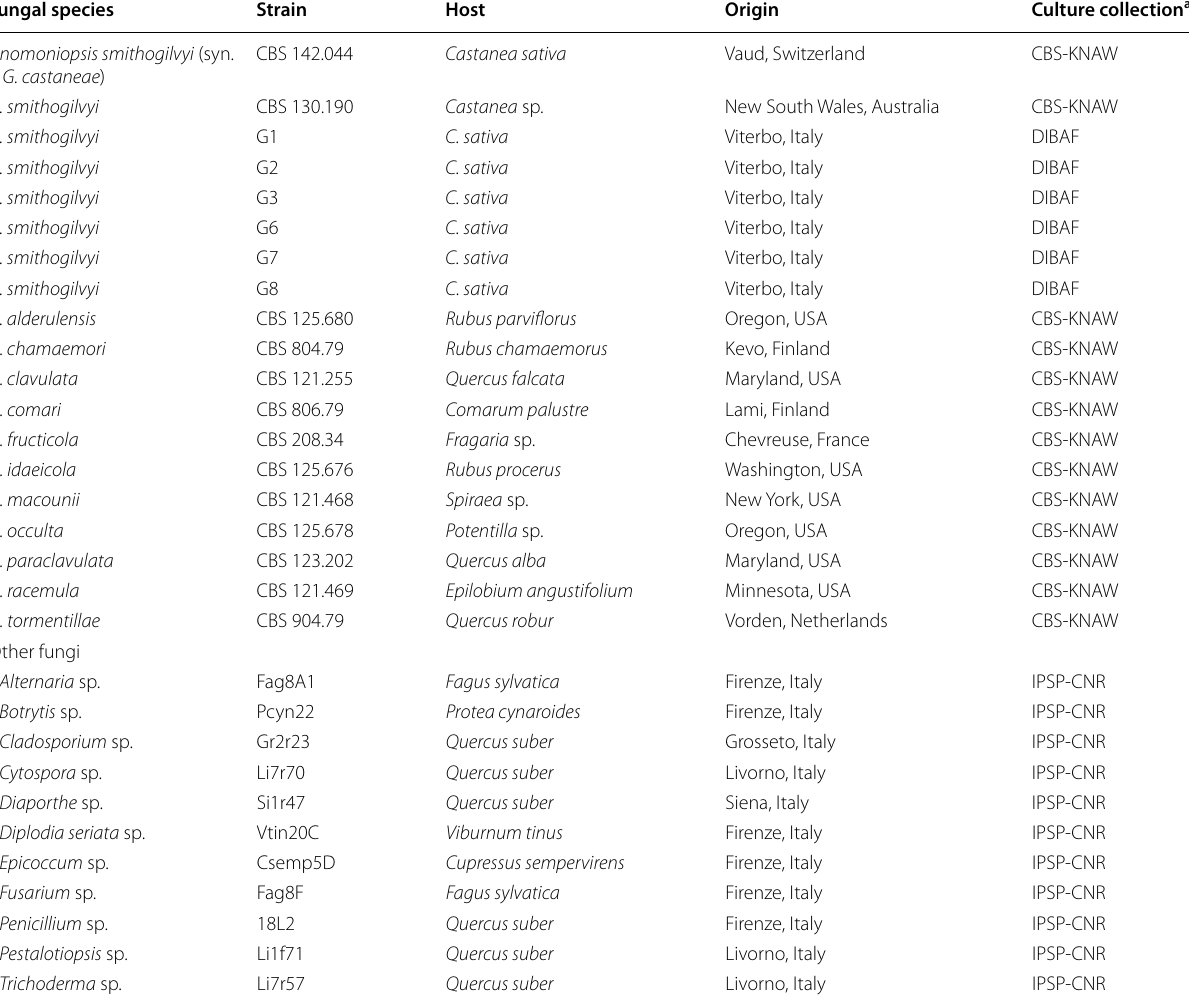
Table 1 List of fungal isolates used in this study Fungal species